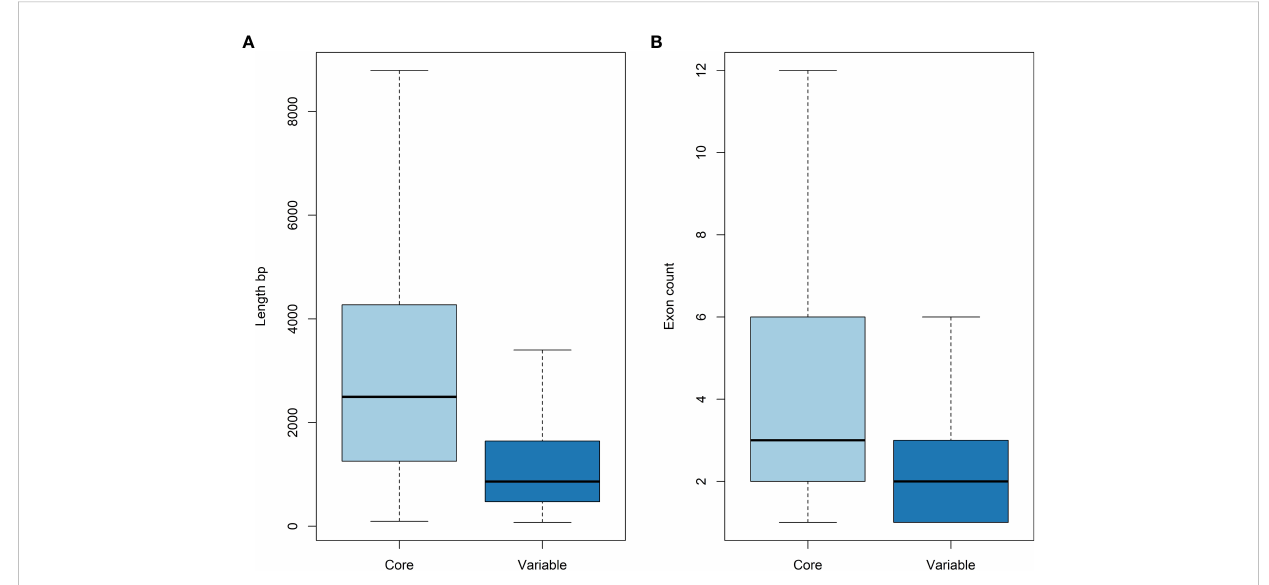
FIGURE 3 Gene length (A) and number of exons (B) of core and variable genes. Variable genes are shorter and have less exons than core